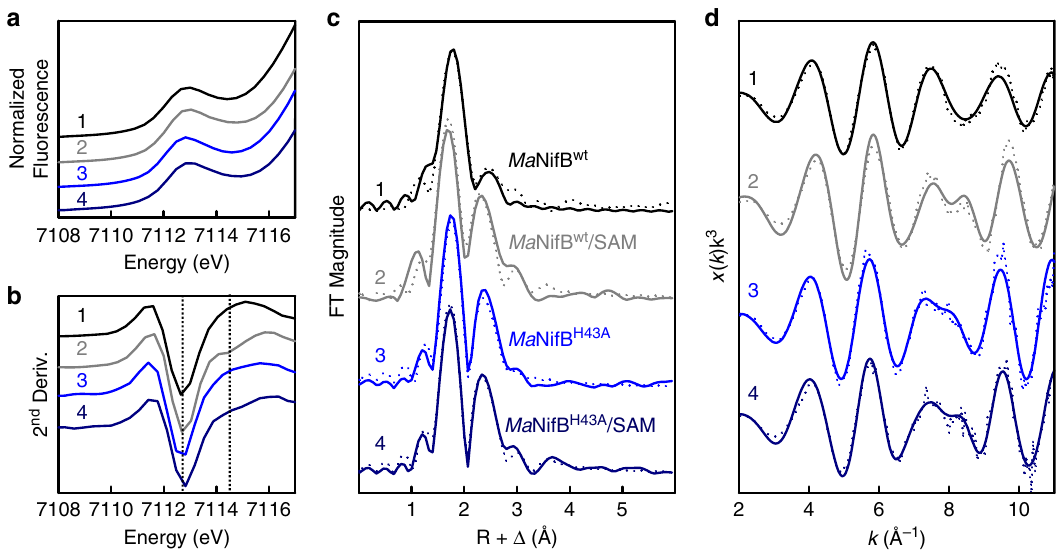
Fig. 4 Fe K-edge XAS analysis of Ma NifB proteins. a Pre-edge regions of the normalized fl uorescence spectra and ( b ) smoothed second derivatives of the pre-edge regions, ( c ) Fourier transforms of the EXAFS data (dotted) and the best fi ts of data (solid), and ( d ) k 3 -weighted EXAFS data (dotted) and the best fi ts of data (solid). Spectra are shown for Ma NifB wt before (1) and after (2, designated Ma NifB wt /SAM) incubation with SAM, and Ma NifB H43A before (3) and after (4, designated Ma NifB H43A /SAM) incubation with SAM. Note that Ma NifB wt carries the K-cluster (a [Fe 4 S 4 ] cluster pair); whereas Ma NifB wt / SAM carries the L-cluster ([Fe 8 S 9 C]). The peaks at ~7112.6eV and ~7114.5 eV of the pre-edge regions are indicated by dashed vertical lines to illustrate the transition from a single peak at ~7112.6eV to two peaks at ~7112.6eV and ~7114.5 eV in the spectrum of Ma NifB wt ( b , 1 vs. a , 2), which corresponds to conversion of the K-cluster to an L-cluster upon incubation of Ma NifB wt with SAM. Such a change is not observed in the case of Ma NifB H43A following the same treatment with SAM ( b , 3 vs. a , 4). The XAS analysis was performed three times independently ( n = 3 independent samples), and representative results are shown in the fi gure. All protein samples have a concentration of 50 mg mL − 1 . All scans were taken at ~10 K. See Supporting Information for more details of EXAFS fi ts.